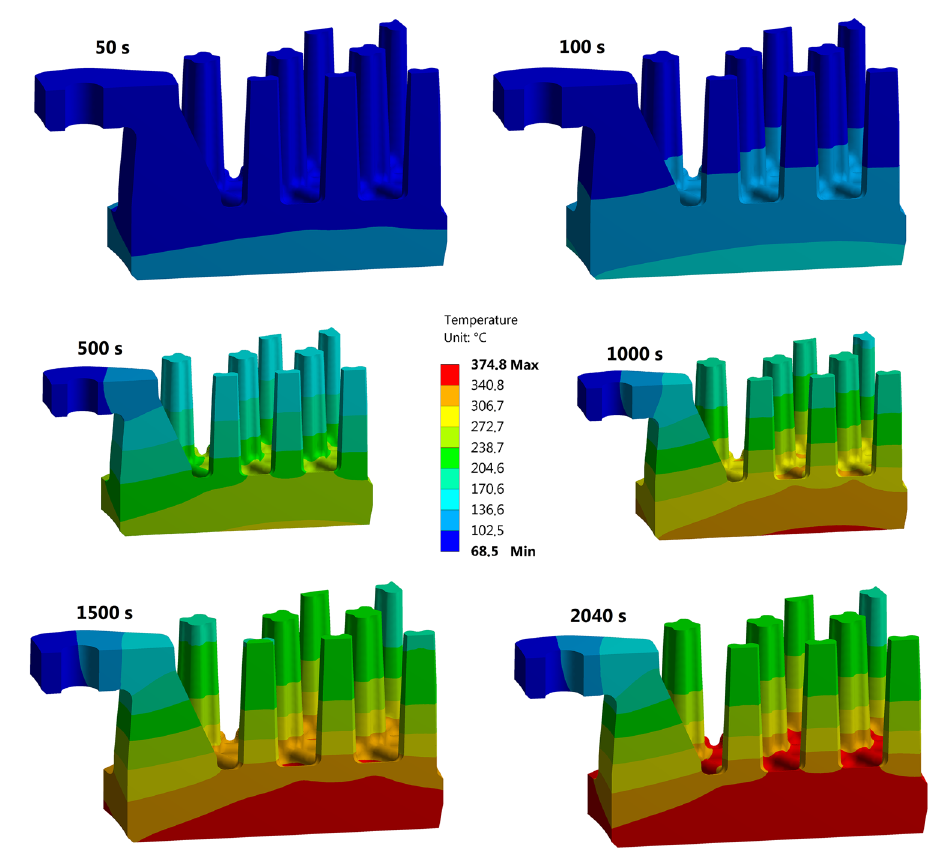
Fig. 9 Temperature distribution for the drag brake scenario